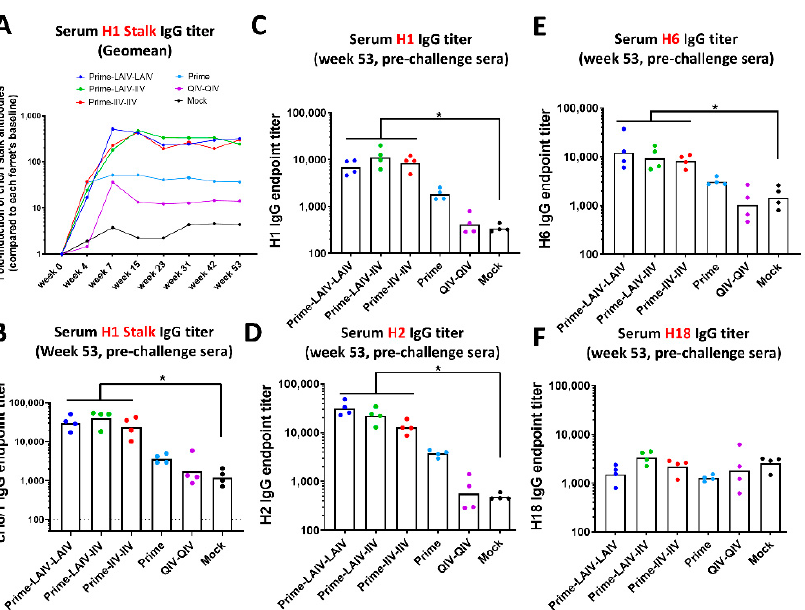
Figure 3. Sequential immunization with cHA-based vaccines induces long-lived broadly reactive HA-specific and H1 stalk antibodies. IgG antibody responses were measured in weeks 0 (pre-prime), 4 (pre-boost1), 7 (pre-boost 2), 15, 23, 31, 42 and/or 53 (pre-challenge). ( A ) Relative to the pre-prime (week 0) serum H1 stalk IgG titers, fold-induction of serum H1 stalk IgG geometric mean endpoint titers against cH6/1 protein at the indicated time points are presented. ( B ) The geometric mean end-point titers of serum H1 stalk IgG on week 53 (pre-challenge) are indicated. The black dashed line indicates the limit of detection for the assay. Serum IgG endpoint titers (y-axis) against ( C ) H1, ( D ) H2, ( E ) H6, and ( F ) H18 were measured prior to pH1N1 challenge infection (week 53). LAIV-LAIV, LAIV-IIV, IIV-IIV, Prime only, and QIV-QIV vaccinated animals are shown as blue, green, red, light blue, and purple, respectively. Mock-immunized animals are shown as black. All animals except for QIV- and mock-immunized ferrets were primed with B-cH9/1 virus. White bars indicate the geometric mean titer (GMT) with individual scatter dot plots. Each point indicates the endpoint titer for each individual ferret ( n = 4/group). Data in ( B to F ) were compared to mock vaccinated animals with non-parametric Mann–Whitney test. The asterisks refer to the level of significance: *: p < 0.05 (each of the three cHA-vaccinated groups has similar statistically significant difference as compared to mock group, with p = 0.0286).